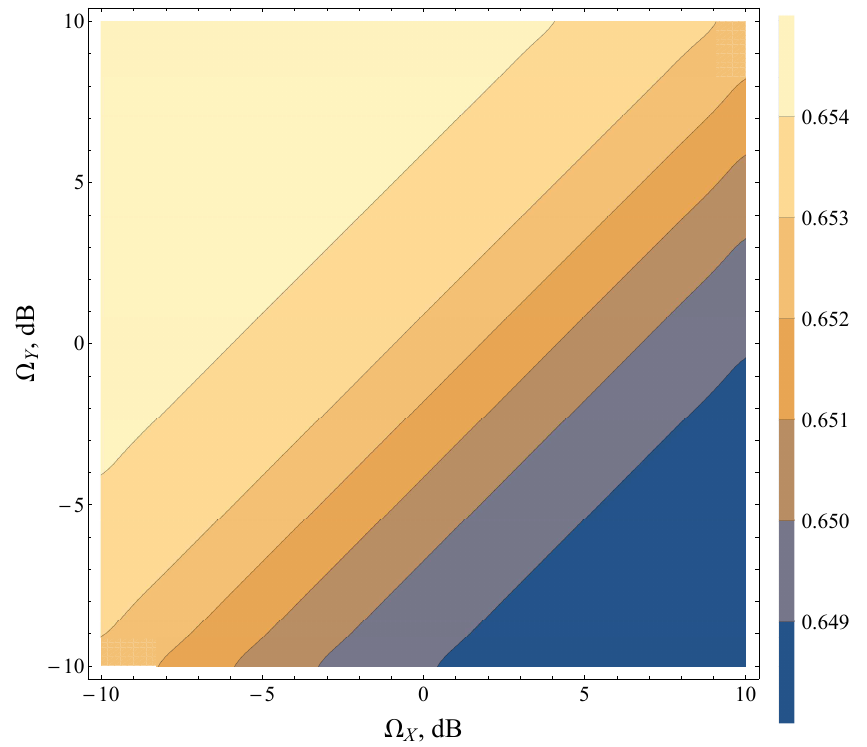
Figure 8. Average AUC contour map for the Beaulieu-Xie shadowed model for various Ω X , Ω Y and ¯ γ = 0 dB, u = 2, m X = 5, m Y =